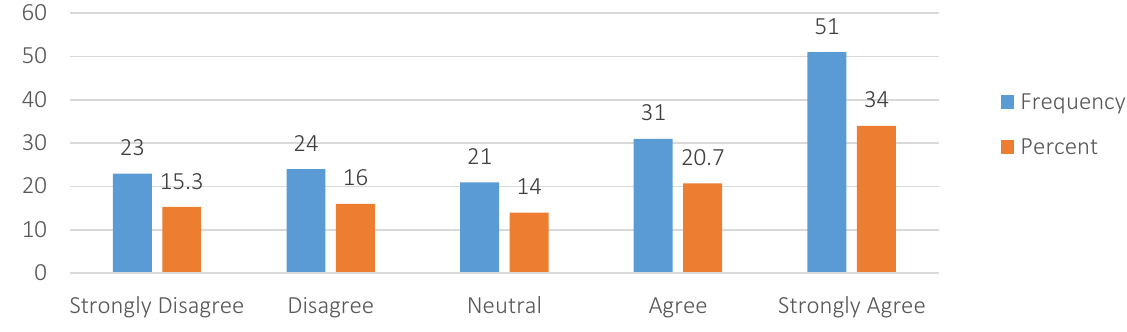
Figure 2. Lack of education and training of owner/manager influences the adoption of MAPs